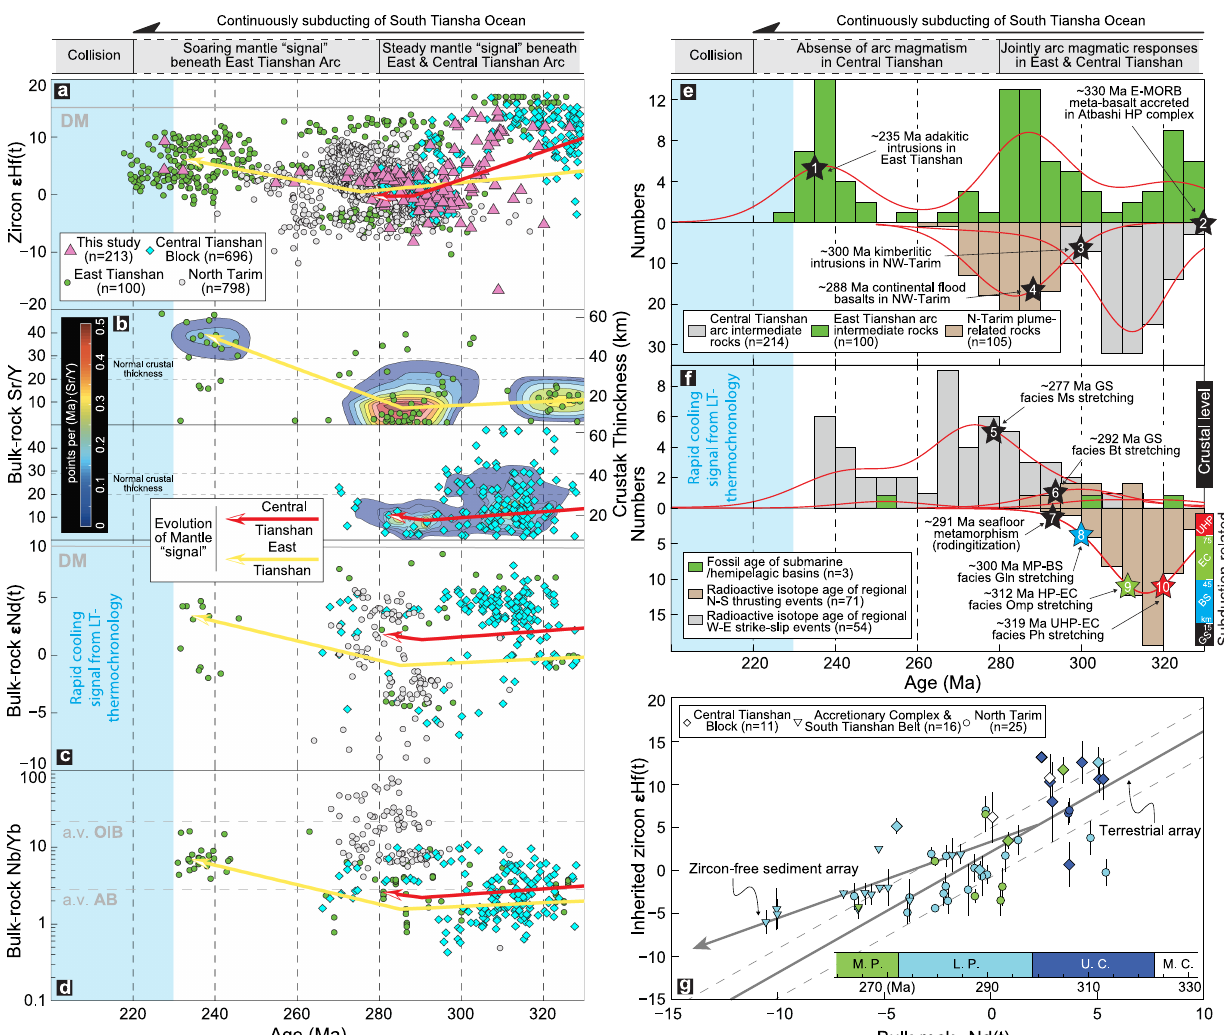
Fig. 7 Plots of compiled multi-disciplinary evidence. It shows the spatial-temporal evolution of a inherited & detrital zircon ε Hf(t), b bulk-rock Sr/Y; data distribution of scatter plot is evaluated by Voronoi density 134 . c ε Nd(t) and d Nb/Yb of arc intermediate rocks among the MFAB, CTS, ETS region, and NTC; crustal thickness is derived from the method of ref. 135 ; yellow and red arrows indicate the evolution of mantle “ signal ” respectively beneath ETS and CTS Arc regions. e KDE plot of ages of regional arc intermediate rocks; ages marked by numbers 1 – 4 with black star are respectively cited from refs. 68,135 – 138 . f KDE plot of ages of regional metamorphism, depositing, and main strike-slip faulting & thrusting events; ages marked by numbers 5 – 10 with black, colored stars are respectively cited from refs. 3,139 . The widespread rapid cooling signal 85 – 89 from low-temperature thermochronology across the STOB, in response to the fi nal amalgamation of southern Altaids, is highlighted by cyan column. g Bulk-rock ε Nd(t)-zircon ε Hf(t) isotope diagram for ~260 – 330 Ma arc or plume-related intermediate rocks from regional tectonic untis; the error bars are derived from the variation of zircon ε Hf(t) values of individual intermediate rock in region. Relevant data are presented in Tables S2 – S4. Compiled regional data are listed in Tables S6 –